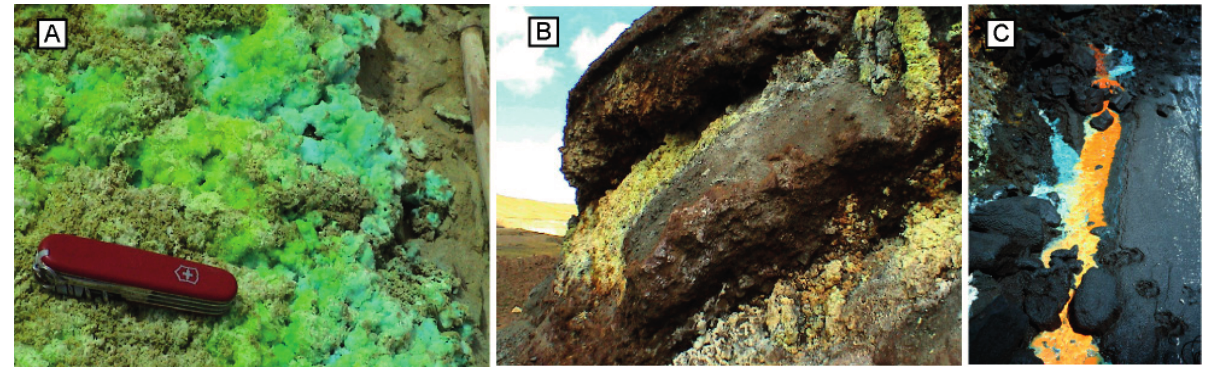
Figure 5. Acid flow precipitates: ( A ) Efflorescent salts surface of acid oxidation zone pH 2.5, Ite Bay, Peru. ( B ) Efflorescent salts at the Excelsior Waste rock dump, Cerro de Pasco, Peru. And ( C ) acid Effluent with chalcoalumite precipitation (light blue) at pH 4.9 and schwertmannite at pH 3.15 (orange-brown) at Ojancos, Copiapo,